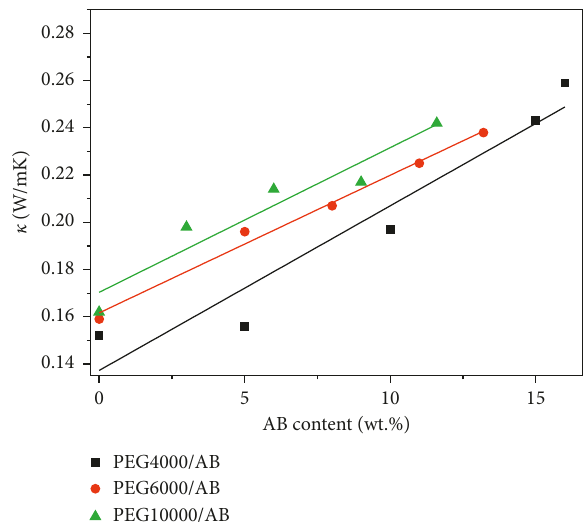
Figure 6: Thermal conductivities with various mass ratios of